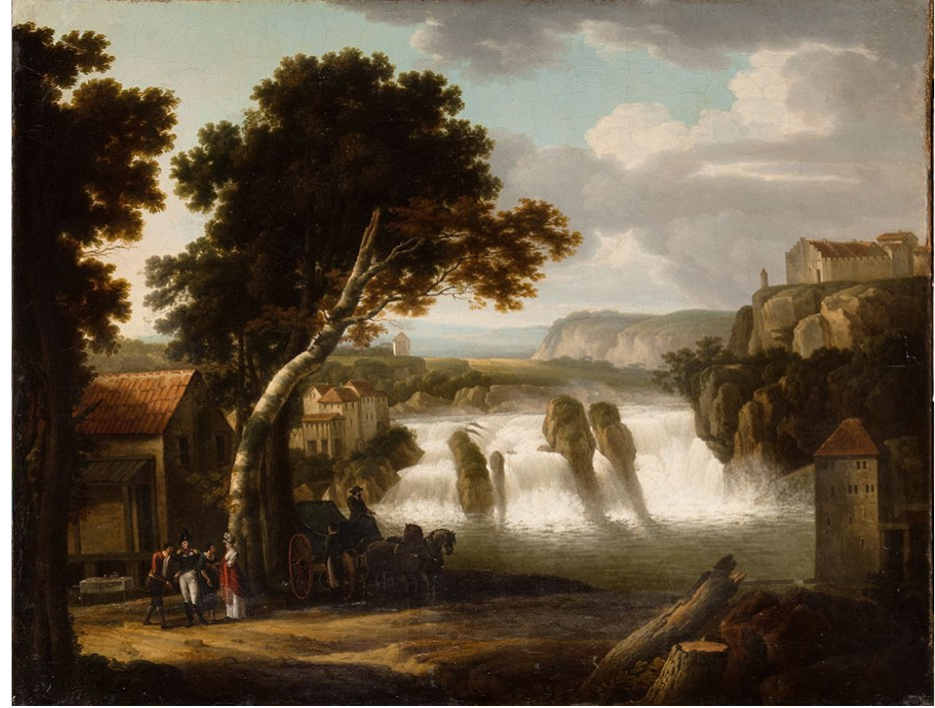
Figure 10. Sylvester Shchedrin. Alexander I at the Schaffhausen Waterfall , 1814. State Russian Museum, Saint Petersburg.